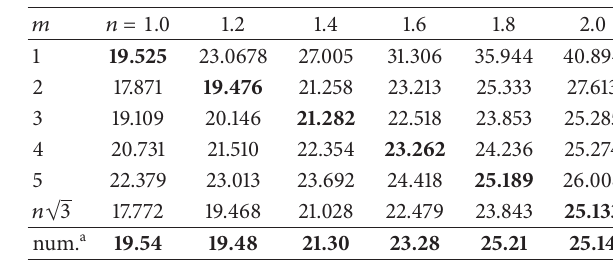
Table 1: Period of sinusoidal oscillations 𝜏 for different values of 𝑚 and 𝑛